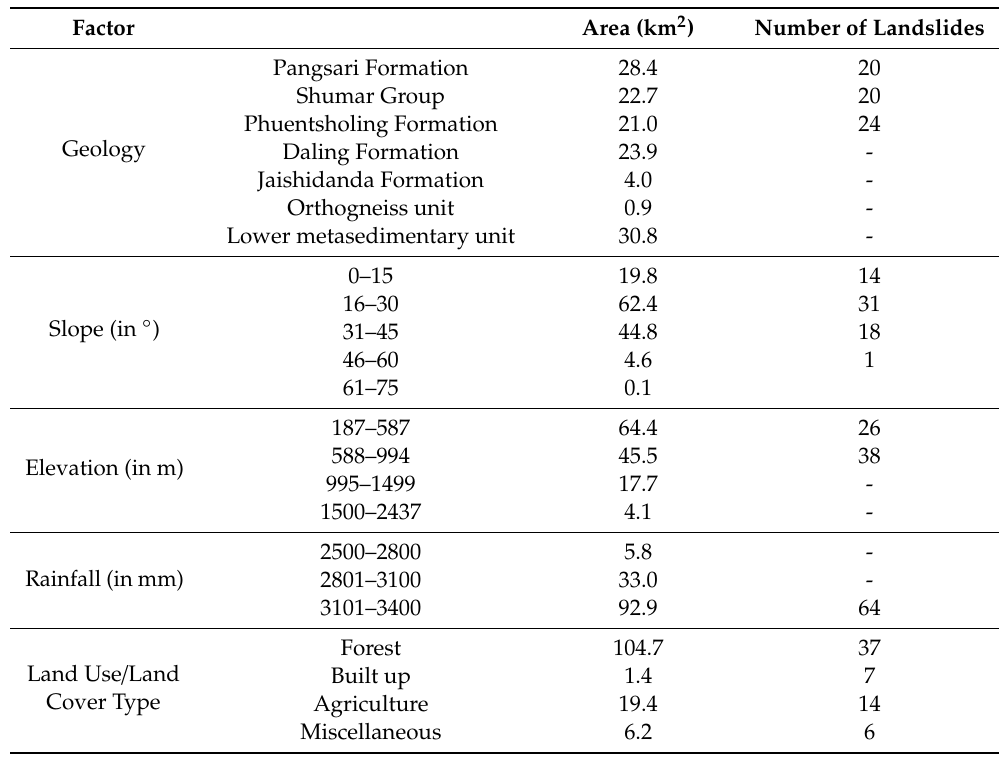
Table 1. Number of landslides under various